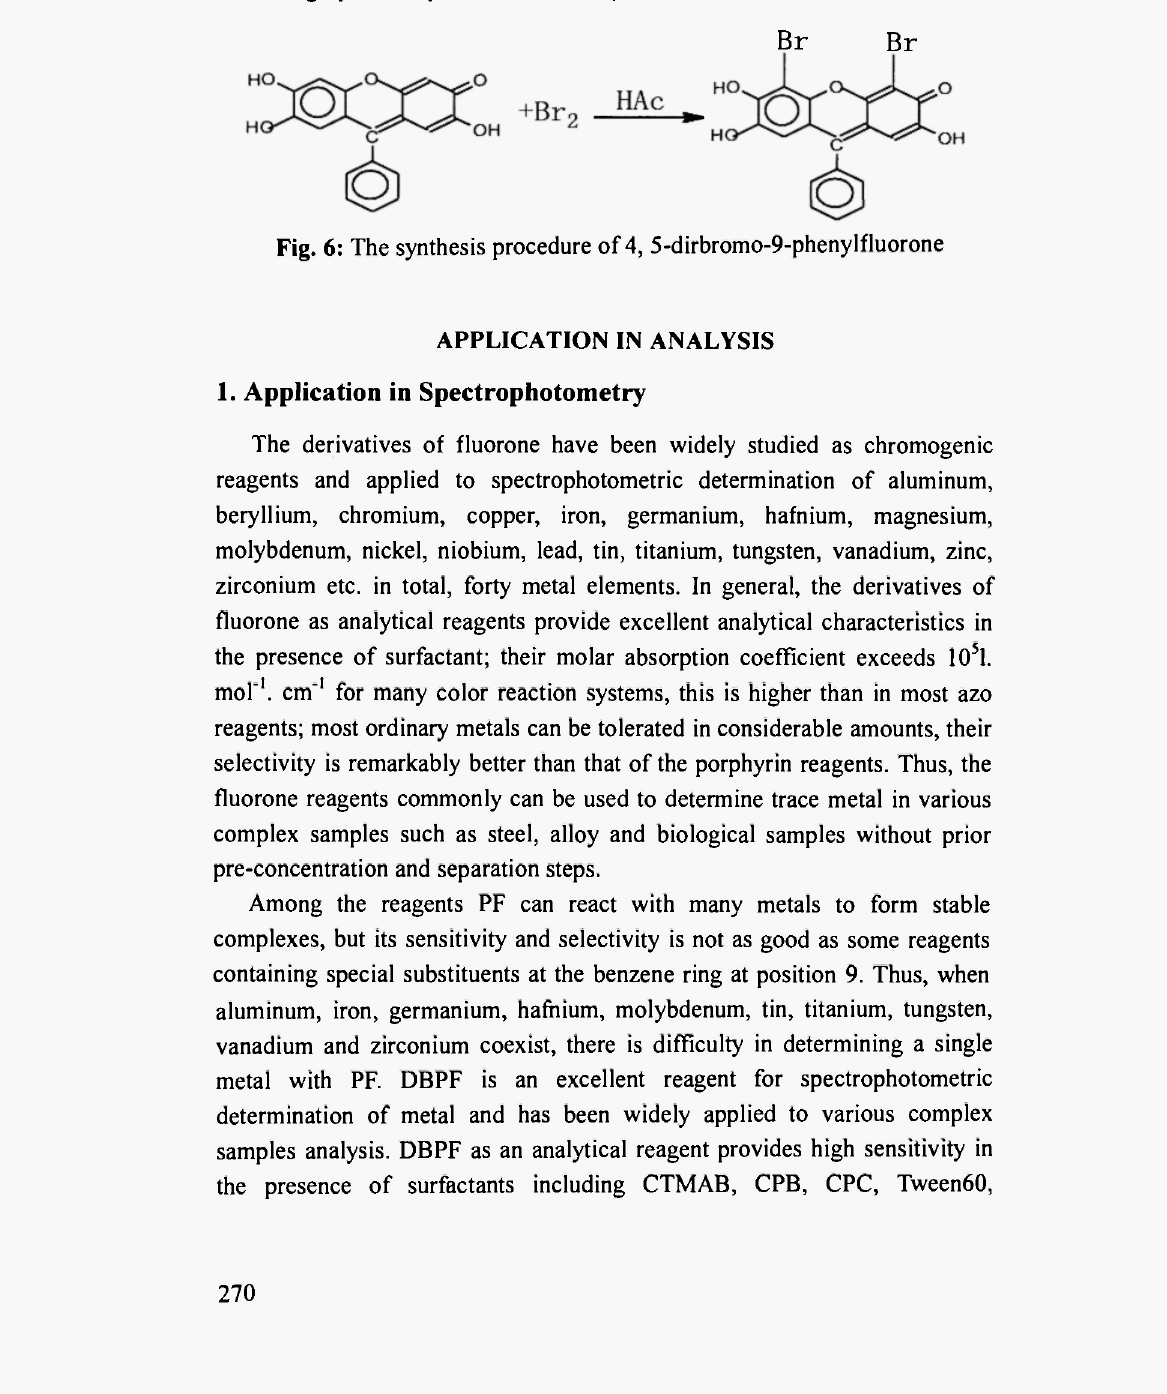
Fig. 6: The synthesis procedure of 4, 5-dirbromo-9-phenylfluorone